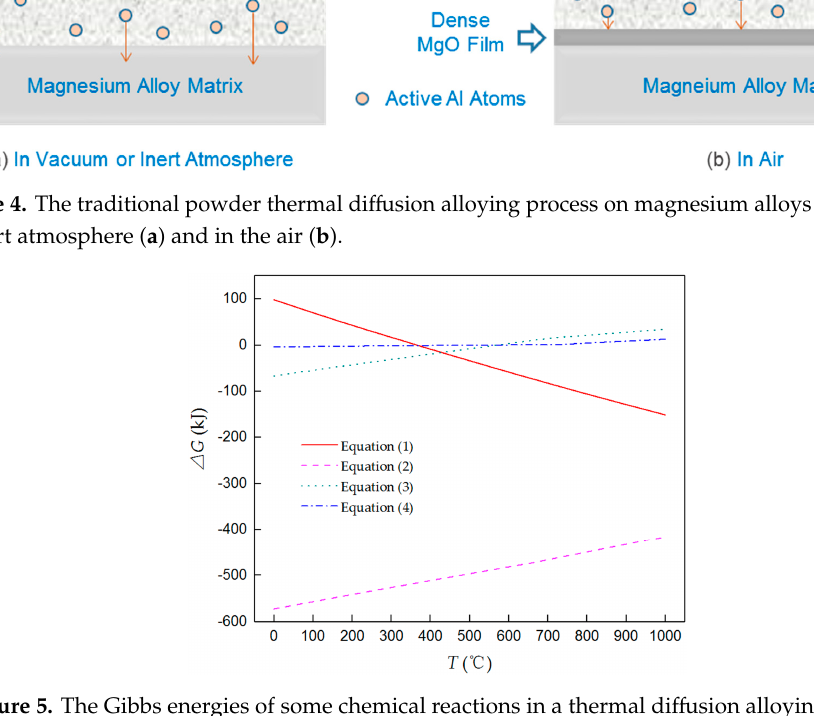
5 Figure 5. The Gibbs energies of some chemical reactions in a thermal di ff usion alloying process.